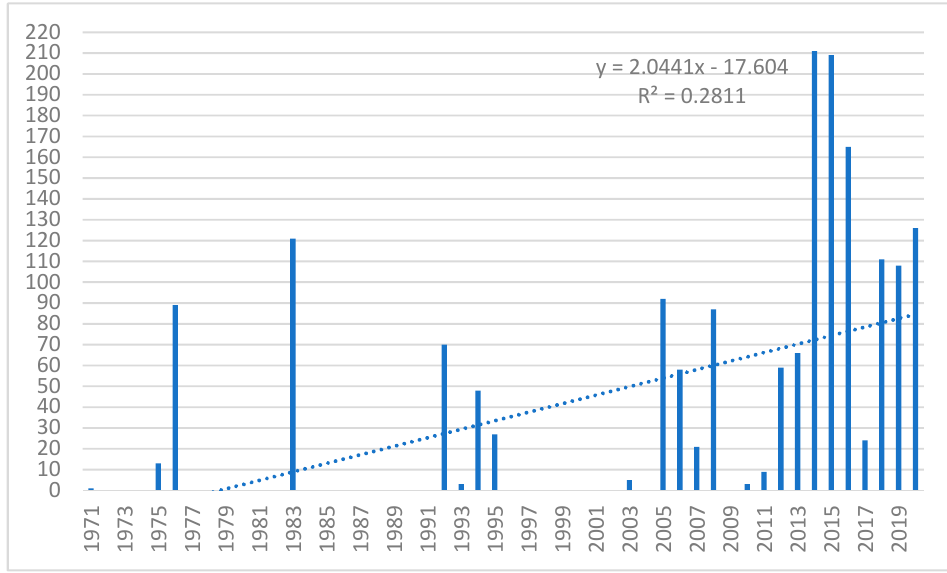
Figure 10. The number of days per year with water discharge levels below SNQ. The total number of days with floods and hydrological droughts in extreme situations constituted 57.8% of all days in the year (2014), whereas the average number of days per year between 2008 and 2020 was 26.4% of all the days per year (Figure 11).